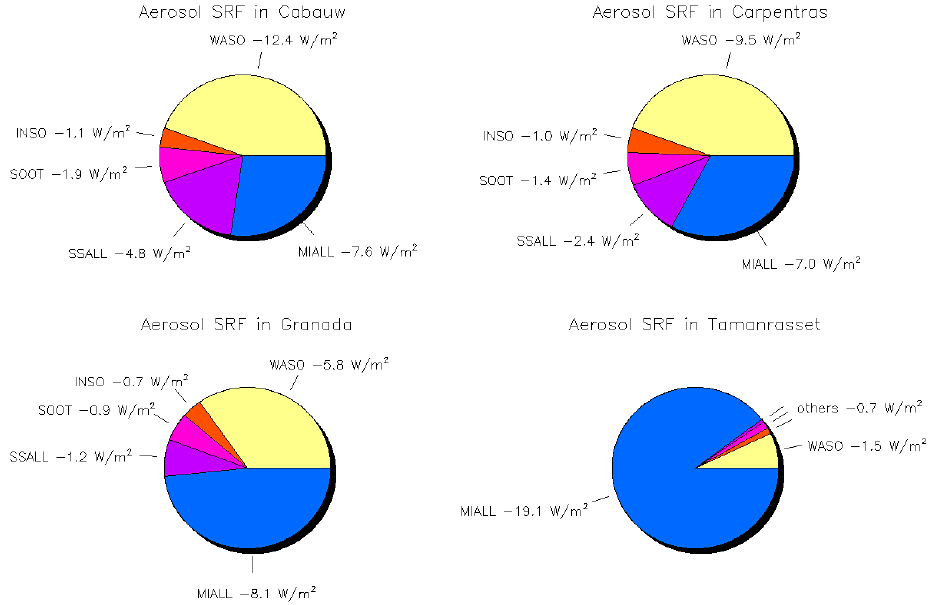
Figure 11. Circle graphs showing the average surface radiative forcing (SFR) in 2011 due to each aerosol component considered in SIRAMix for a selected set of